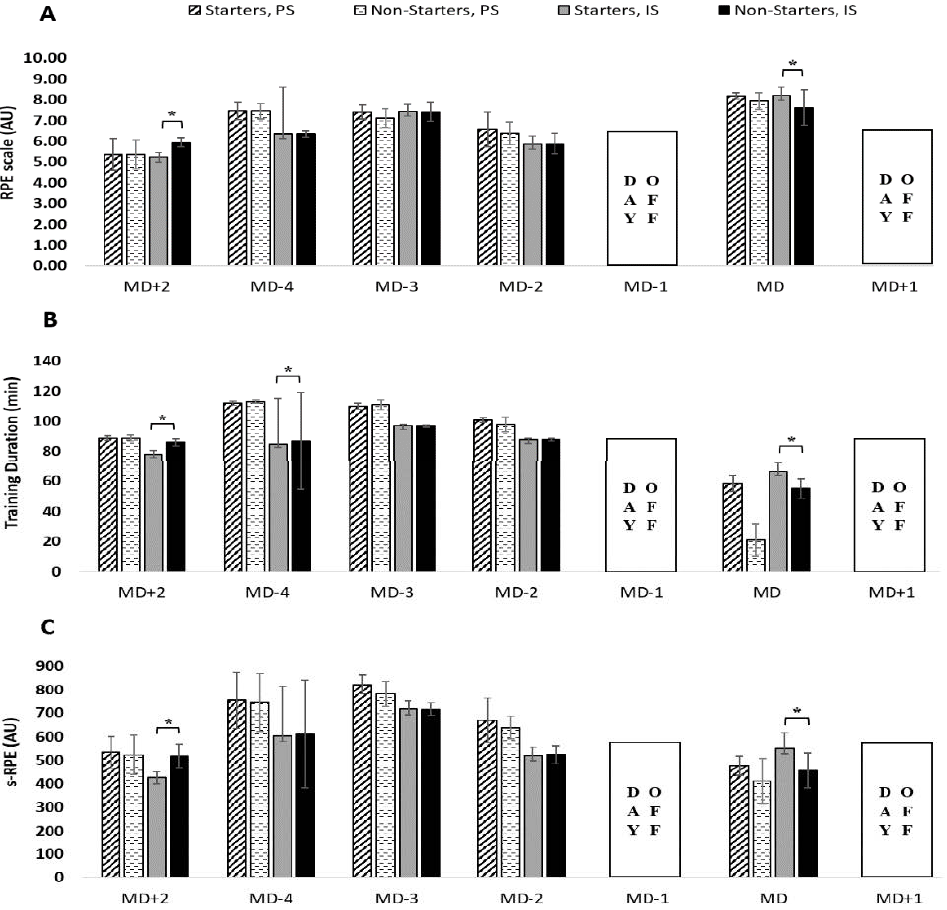
Figure 3. Training load in full-season for RPE ( A ), training duration ( B ), and s-RPE ( C ) with respect to days before a competitive match between player status. Abbreviations: PS—Pre-season; IS—In-season; ( * ) denotes significant differences between starters with non-starters, all p ≤ 0.05.